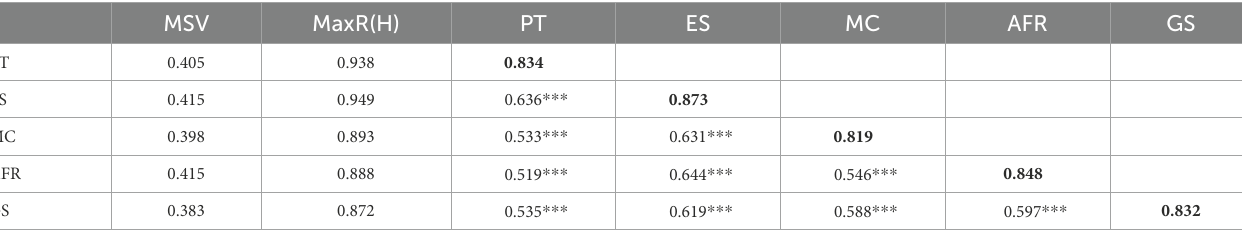
TABLE 4 Inter-construct correlations and validity